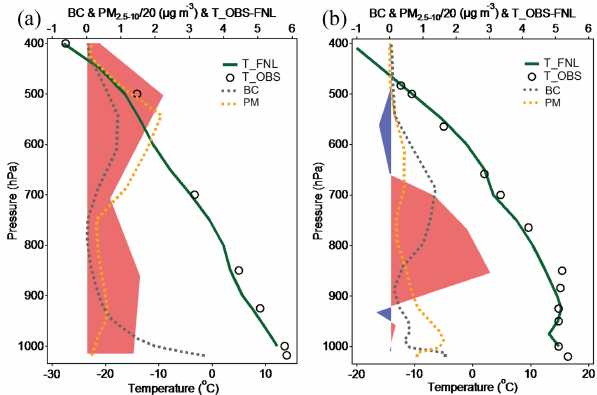
Figure 12. Vertical profiles of air temperature from NCEP FNL Op- erational Global Analysis data, the corresponding radiosonde obser- vations (black circles), temperature difference between observation and the FNL data (filled red and blue to zero), and calculated BC and PM 2 . 5–10 for (a) Anqing (30.5 ◦ N, 117.1 ◦ E) and (b) Shantou (23.3 ◦ N, 116.7 ◦ E) at 20:00LT on 23 March